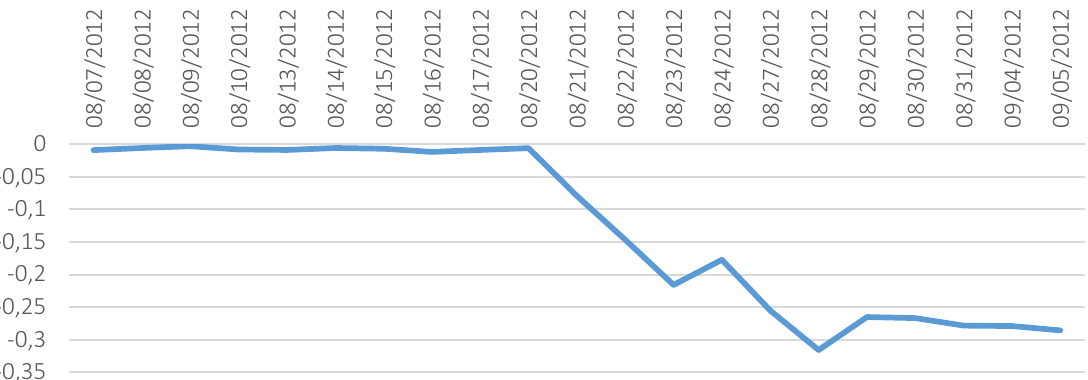
Figure 1. ACB’s CAR [–10;10] for the first event in 2012